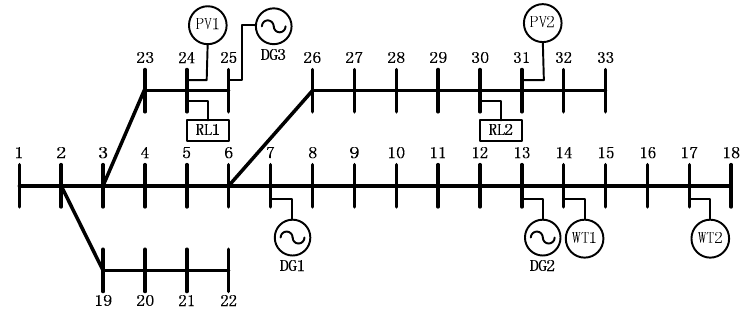
Figure 1. Single line diagram of the IEEE ‐ 33 bus test system. Table 1. DGs’ characteristics and cost data.